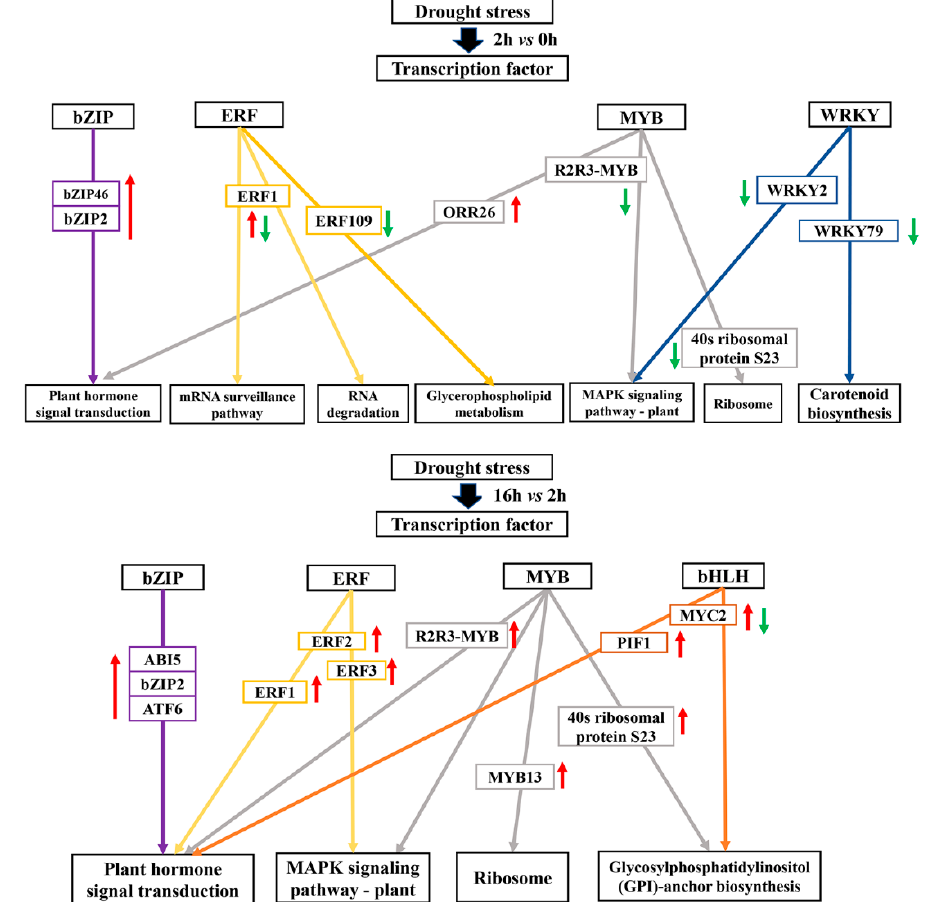
Figure 11. Proposed working model for drought stress transcription factor signaling network in Kentucky bluegrass. The red arrow represents the up-regulated gene, the green arrow represents the down-regulated gene. The purple frame represents the bZIP family transcription factor, the yellow frame represents the ERF family transcription factor, the gray frame represents the MYB family transcription factor, the blue frame represents the WRKY family transcription factor, and the orange frame represents the bHLH family transcription factor.